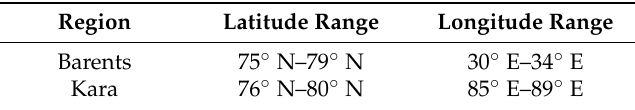
Table 1. Localisation of both examined TCWV regions of the Barents and Kara